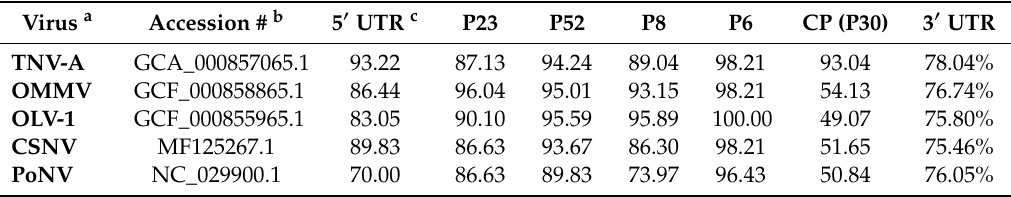
a Current members of the Alphanecrovirus genus by virtue of primary genome and encoded protein sequence structure; b Indicates NCBI Accession number (#) used as reference; c Similarity (%) of the 5 ′ and 3 ′ UTR compared at the nucleotide level. Similarity of ORFs for putative proteins P23, P52, P8, P6, and P30 were compared at the amino acid sequence level.